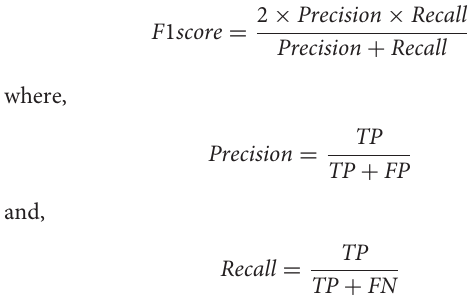
average AUC of each set during feature selection was calculated using stratified 5-fold cross validation. The performance of each set of features was then compared to select the optimum